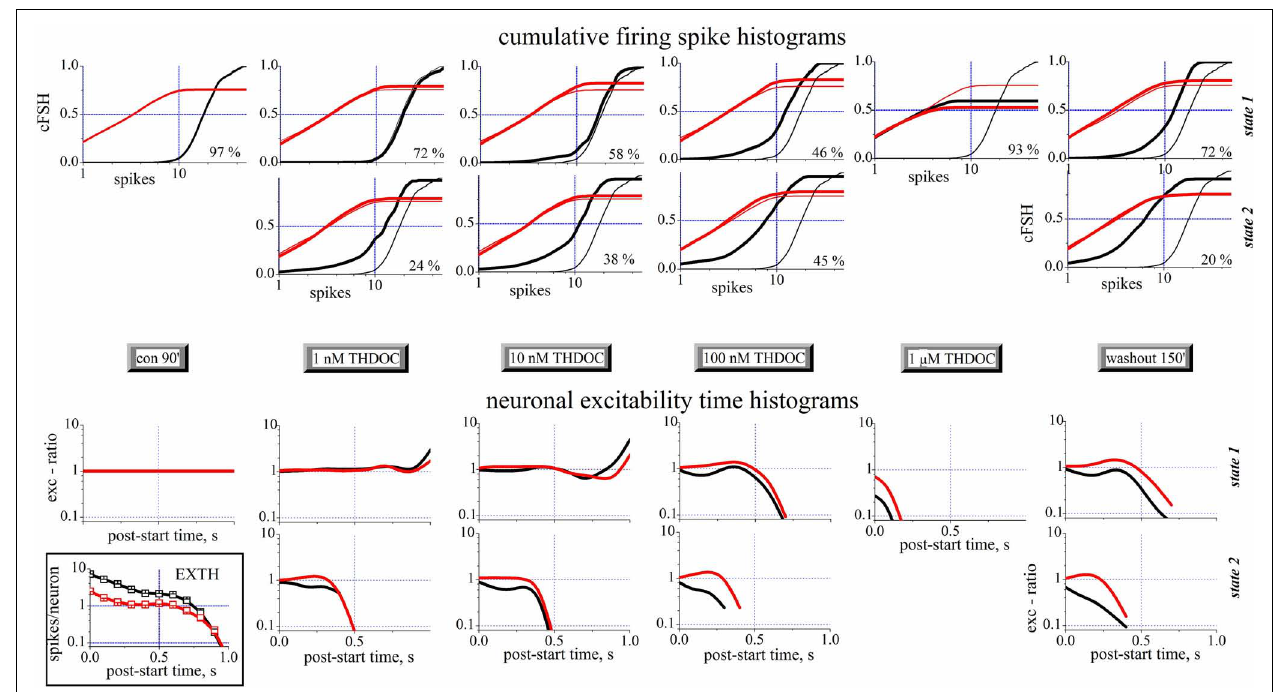
cFSH data found in control are superimposed as thin lines. Lower panels : Exc-ratio histograms (which report the ratio of EXTHs evaluated in the i -th segment with respect to control segment). In the inset below, for control, the excitability time histograms (EXTH) are shown. Control and wash-out segments had durations of 30 min ( ∼ 110 bursts) while all the others had durations of 10 min ( ∼ 40 burst). In control, only one state was detected, while afterTHDOC application, a second state appeared co-existing with the first one. Note that after 3.5 h of wash-out, the second state was still present. Data from one of the experiments shown in Figures 1E–H